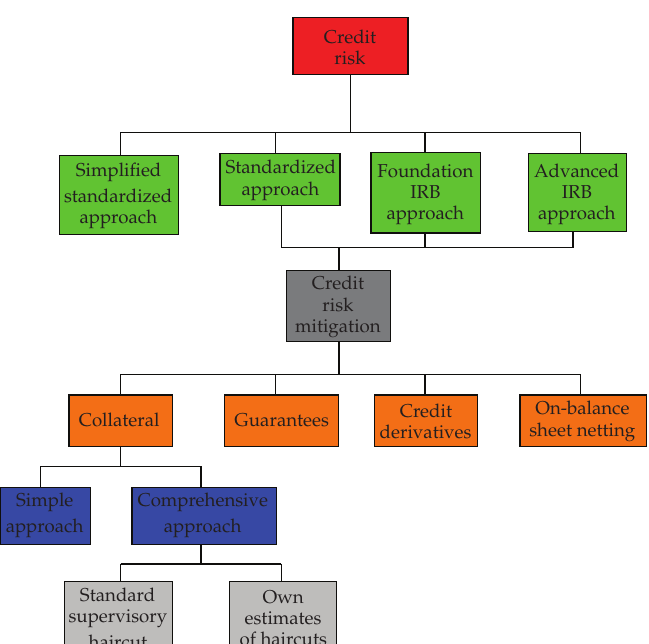
Figure 8: Diagrammatic overview of Basel II Credit